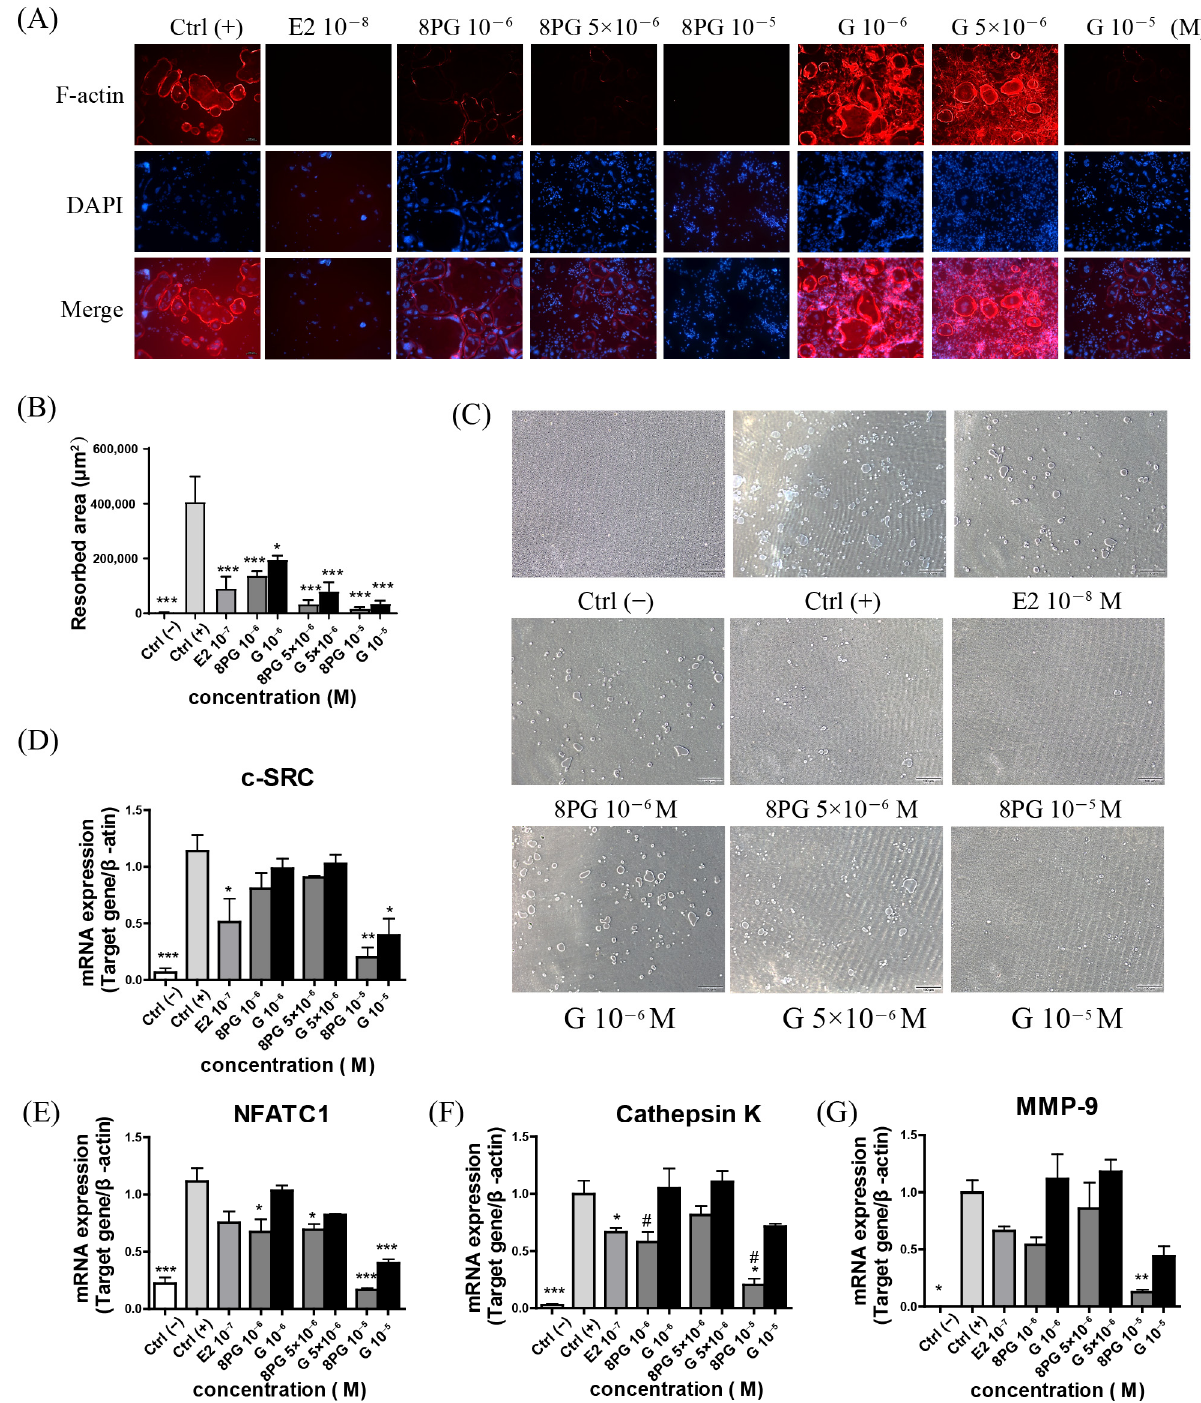
Figure 5. The effects of 8PG and genistein (G) on osteoclastic activity and the mRNA expression of osteoclast-related genes in RANKL-induced RAW264.7 cells. ( A ) Representative fluorescence images of F-actin ring formation in osteoclasts from RAW264.7 cells under osteoclast differentiation medium for 4 days. F-actin ring (red), DAPI (blue). Scale bar is 100 μ m. ( B ) The total area of resorbed pits. ( C ) Representative images of bone-resorption pits. Scale bar: 100 μ m; (D–G) mRNA expression of RANKL-induced osteoclast-associated genes, including c-SRC ( D ), NFATC1 ( E ), Cathepsin K ( F ) and MMP-9 ( G ). Results were expressed as mean ± SEM (n = 3), * p < 0.05, ** p < 0.01, *** p < 0.001 versus Ctrl (+); # p < 0.05 vs. genistein (G)-treated group at the same concentrations.